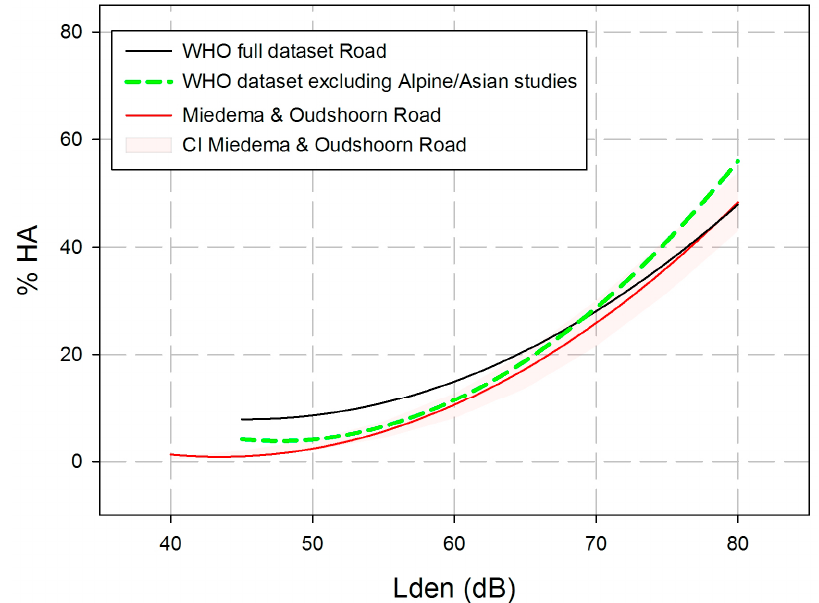
Figure 7. Quadratic regressions of the relation between L den and the calculated %HA for 25 road traffic noise studies, (“full WHO data set”, black) vs. 10 studies (dashed green, same data set excluding the Alpine and Asian studies). For comparison, the exposure ‐ response function by Miedema and Oudshoorn ([4], road) is shown (red), together with the respective confidence interval. Note: The black and green curves are derived from aggregated secondary data, while the red curve is derived from individual data.